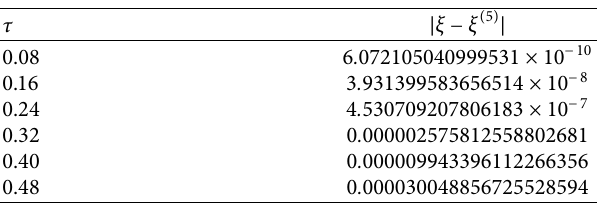
Figure 8: The absolute errors of Example 4. Table 4: The absolute errors for Example 4 at λ